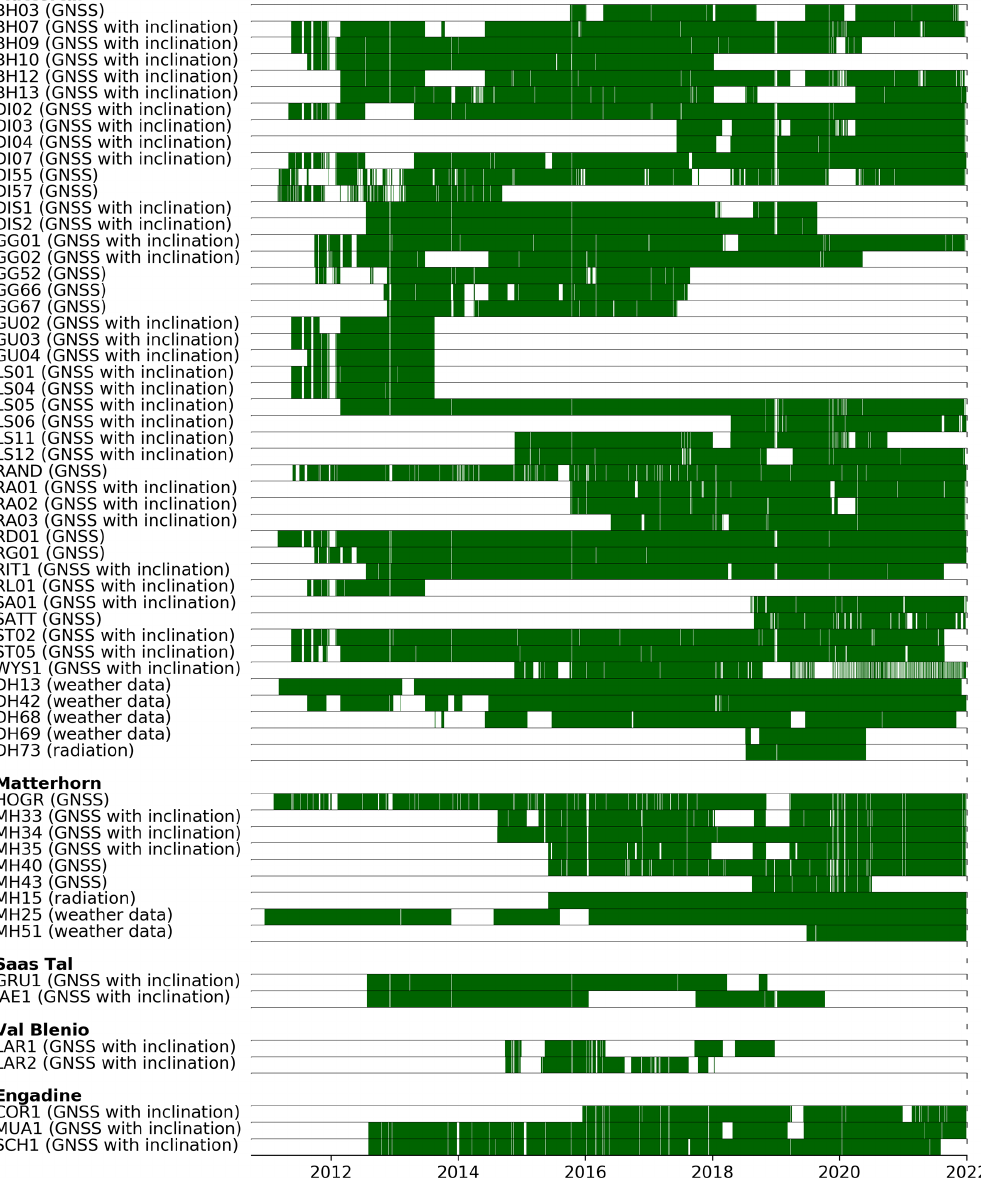
Figure A1. Data availability for all primary data products. The time periods when data are available are indicated in green.